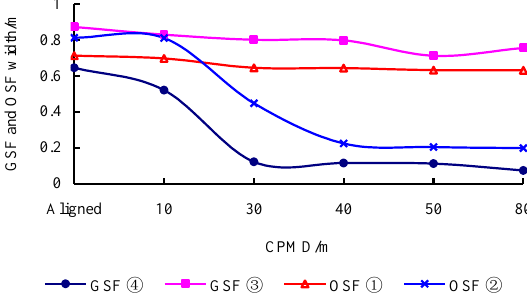
Figure 16. OSF width and GSF width vs. CPMD.